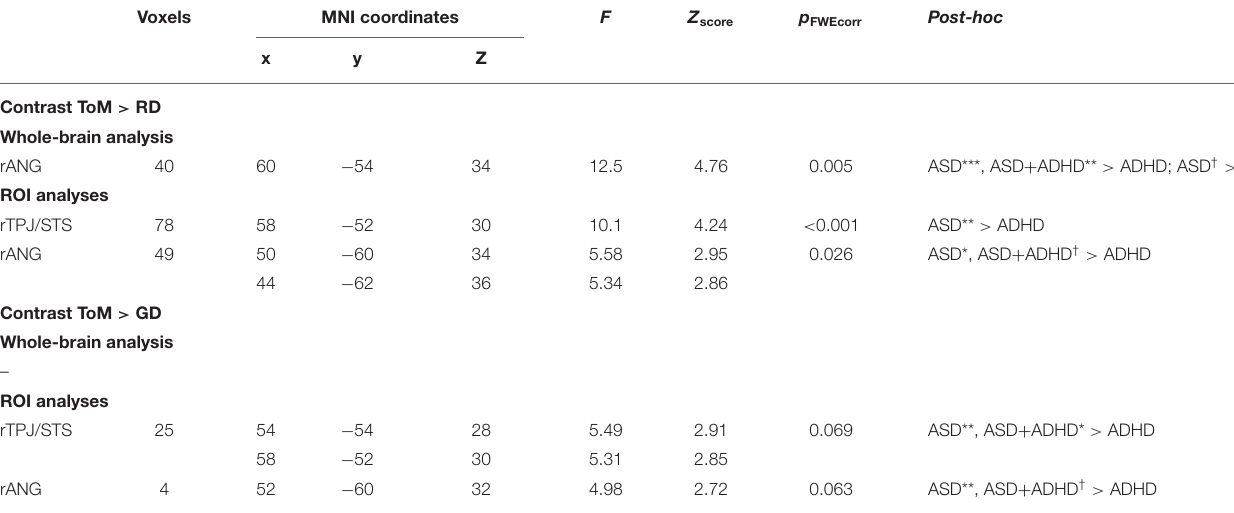
TABLE 2 | Significant peak activation by cluster for the contrasts theory of mind (ToM) over random (RD) and goal-directed (GD) motion in the whole-brain and region-of-interest (ROI) analyses. Voxels MNI coordinates F Z score p FWEcorr Post-hoc x y